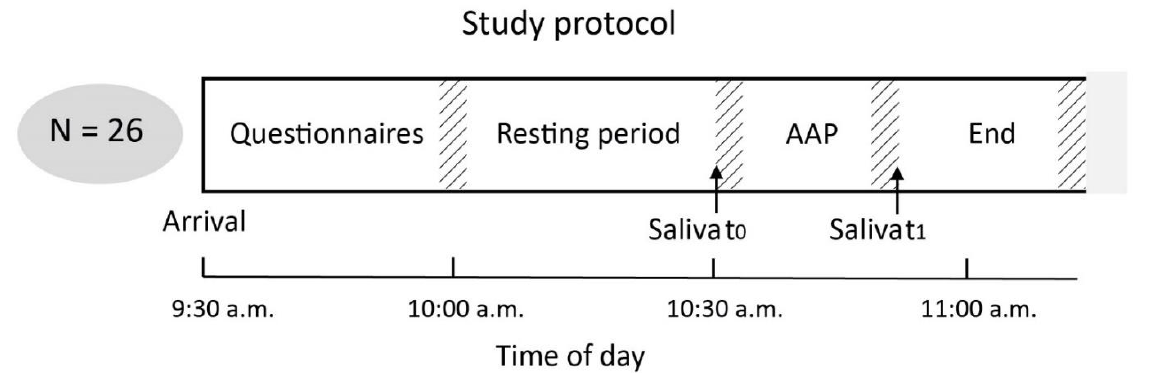
Figure 1. Graphical representation of the study protocol including the experimental sections, time intervals and time points (t 0 = Before AAP, t 1 = After AAP) of saliva collection. AAP, Adult Attachment Projective Picture System. Notification: Hatched areas indicate inter-individual differences for the duration of the AAP. The given time intervals represent the mean duration time (in min). For detailed information about grand averages and group-wise averages of duration times, also see Table 1.